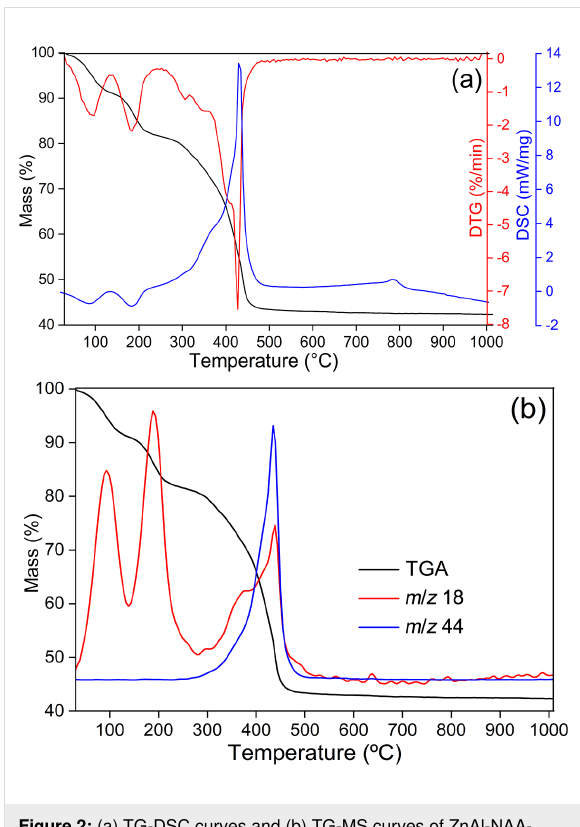
Figure 2: (a) TG-DSC curves and (b) TG-MS curves of ZnAl-NAA-